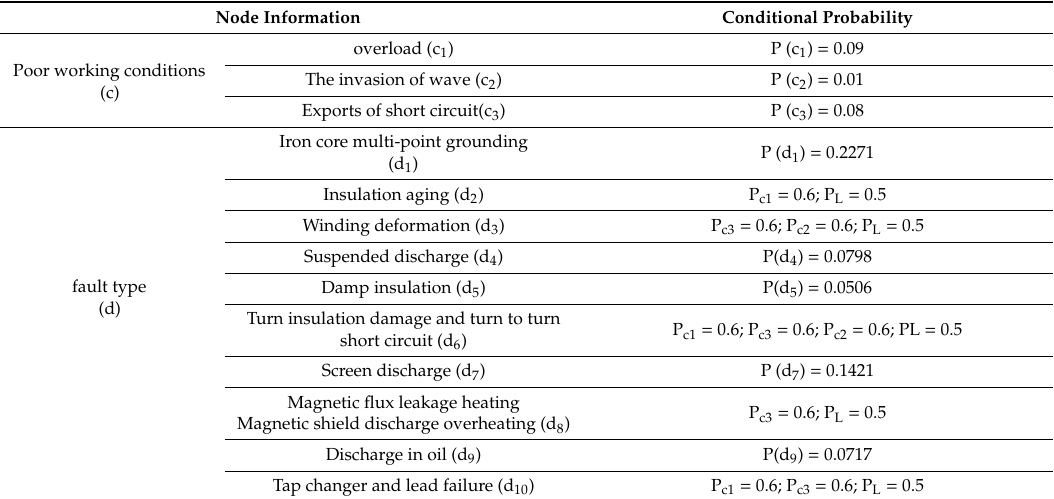
Table 6. Conditional probability